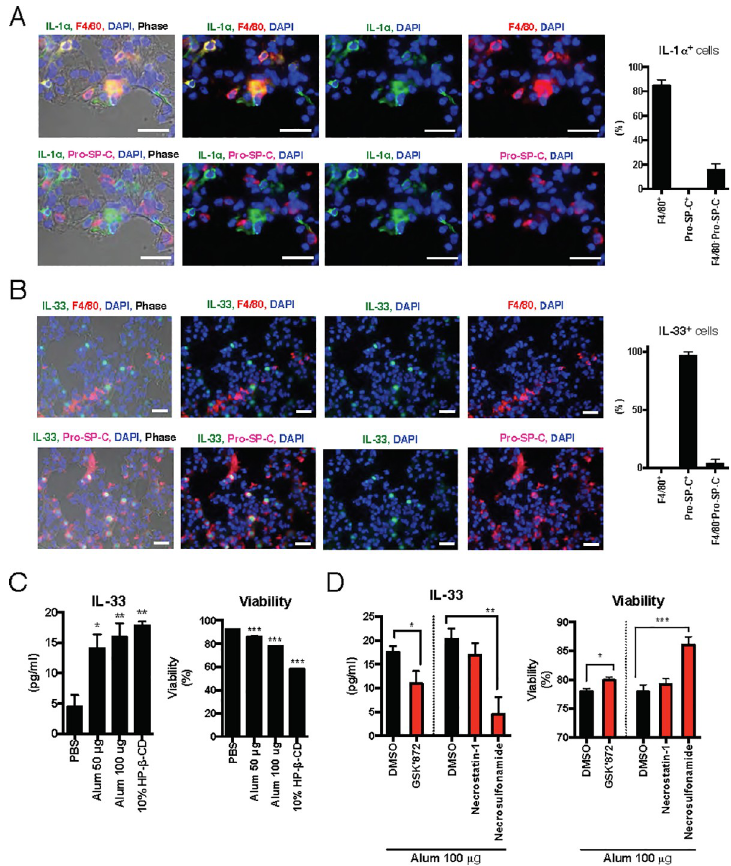
Fig 3. Alveolar epithelial cells lead to necroptosis-dependent IL-33 secretion. Nontreated mice were euthanized, and the lungs were collected. Fresh frozen sections were prepared and stained with anti-IL-1 α Ab, anti-F4/80 Ab, anti- Pro-SP-C Ab and DAPI ( A ), or anti-IL-33 Ab, anti-F4/80 Ab, anti- Pro-SP-C Ab, and DAPI ( B ). In both A and B , the top and bottom images are from the same section, however, there are different fluorescent combinations. Images